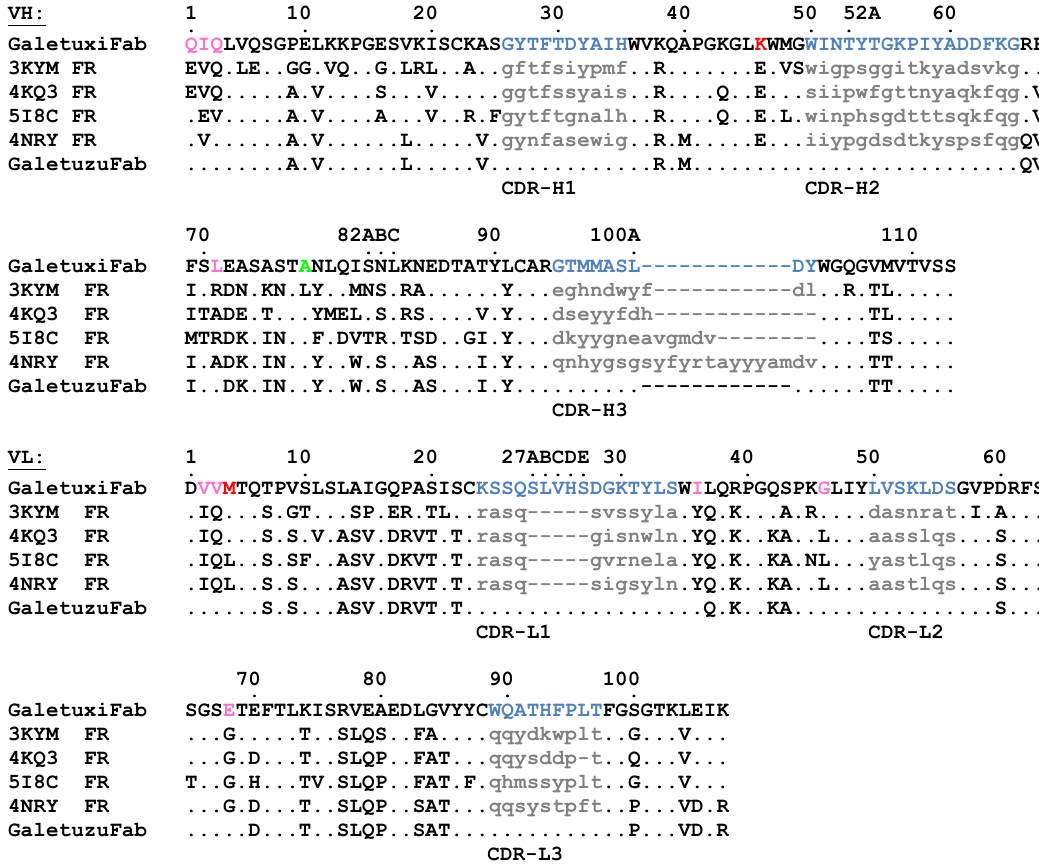
Figure 3. Amino acid sequence alignment of the V-regions cloned from the M3/38 hybridoma in form of the chimeric αhGal3-Fab (GaletuxiFab) with suitable human template sequences for CDR grafting as well as the finally humanized version, GaletuzuFab. Human V-region templates considered in this study were from a mAb targeting the surface glycoprotein LINGO-1 (PDB ID: 3KYM), an anti-IL-17A antibody (PDB ID 4KQ3), the HIV-1 neutralizing Fab VRC34.01 (PDB ID: 5I8C) and from the HIV-1 neutralizing antibody m66 (PDB ID: 4NRY), which appeared to offer the most promising acceptor framework to yield GaletuzuFab. Sequences are numbered according to Kabat 20 . CDRs of the donor antibody are highlighted in blue whereas those of the acceptor antibodies are shown in lower case letters. The definition of CDR-L1 also includes positions L26–L30 as proposed by Chothia et al. 31 . Initially introduced back-mutations for CDR grafting are highlighted in pink (with an additional position for 3KYM in green), second generation back-mutations are colored 4). As result, back-mutation of the residues Lys(H46) and Met(L4) to the original rat V-sequences showed positive effects on the antigen affinity. Quantitative ELISA measurements revealed K D values of 1.3 ± 0.1 nM for the Lys(H46) mutant and of 1.5 ± 0.1 nM for the Met(L4) mutant, compared with a value of 2.3 ± 0.2 nM measured for "4NRY" side by side, thus approaching the affinity of the chimeric αhGal3-Fab towards hGal3, with K D = 1.2 ± 0.2 nM in this experiment (Fig. 5C). Both residues are located in close proximity to the antigen-binding site, suggesting a direct interaction with the presumed full length hGal3 antigen, which is more extended than the minimal epitope peptide visible in the crystal structure with the chimeric αhGal3-Fab. Aiming at a synergistic effect, both mutations Lys(H46) and Met(L4) were combined on the "4NRY" back- ground, which resulted in the final humanized version, dubbed GaletuzuFab. Measured side by side with the chi- meric αhGal3-Fab (GaletuxiFab), GaletuzuFab showed an indistinguishable K D value of 1.3 ± 0.2 nM in the ELISA (Fig. 6). Even lower matching values of 0.34 ± 0.02 nM for GaletuzuFab and of 0.29 ± 0.02 nM for GaletuxiFab were measured in SPR experiments, which further confirmed the functional humanization of the αhGal3-Fab. Taken together, nine back-mutations to the rodent sequence were introduced into the human acceptor framework "4NRY": Ile(H2), Lys(H46), Leu(H71), Val(L2), Val(L3), Met(L4), Ile (L36), Gly(L46) and Glu(L68) (see Fig. 3). Site‑specific labelling of the humanized Fab.